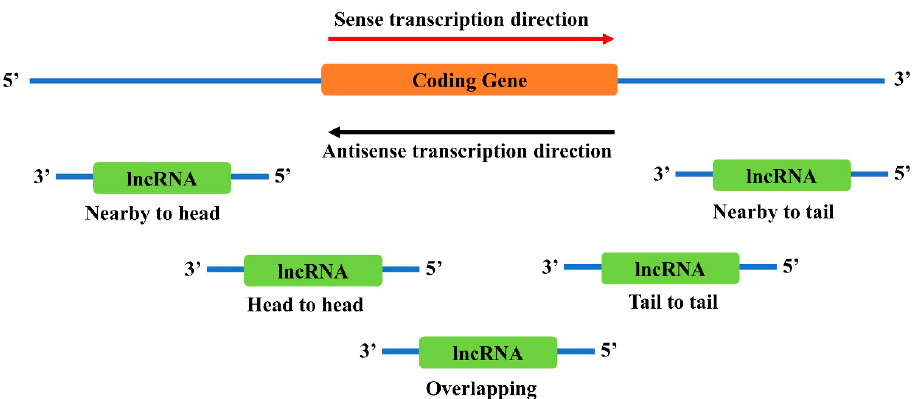
Figure 2. Genomic locations of antisense neighborhood lncRNAs to a sense coding gene. Depending on the relative locations towards the coding gene, neighborhood lncRNAs are categorized into several types: nearby to head, the 5’ end of the lncRNA is close to the 5’ end of the coding gene; head to head, the 5’ end of both genes are aligned together; overlapping, the antisense lncRNA overlaps with the sense coding gene; tail to tail, the 3’ end of both genes are aligned together; and nearby to tail, the 3’ end of the lncRNA is close to the 3’ end of the coding gene.